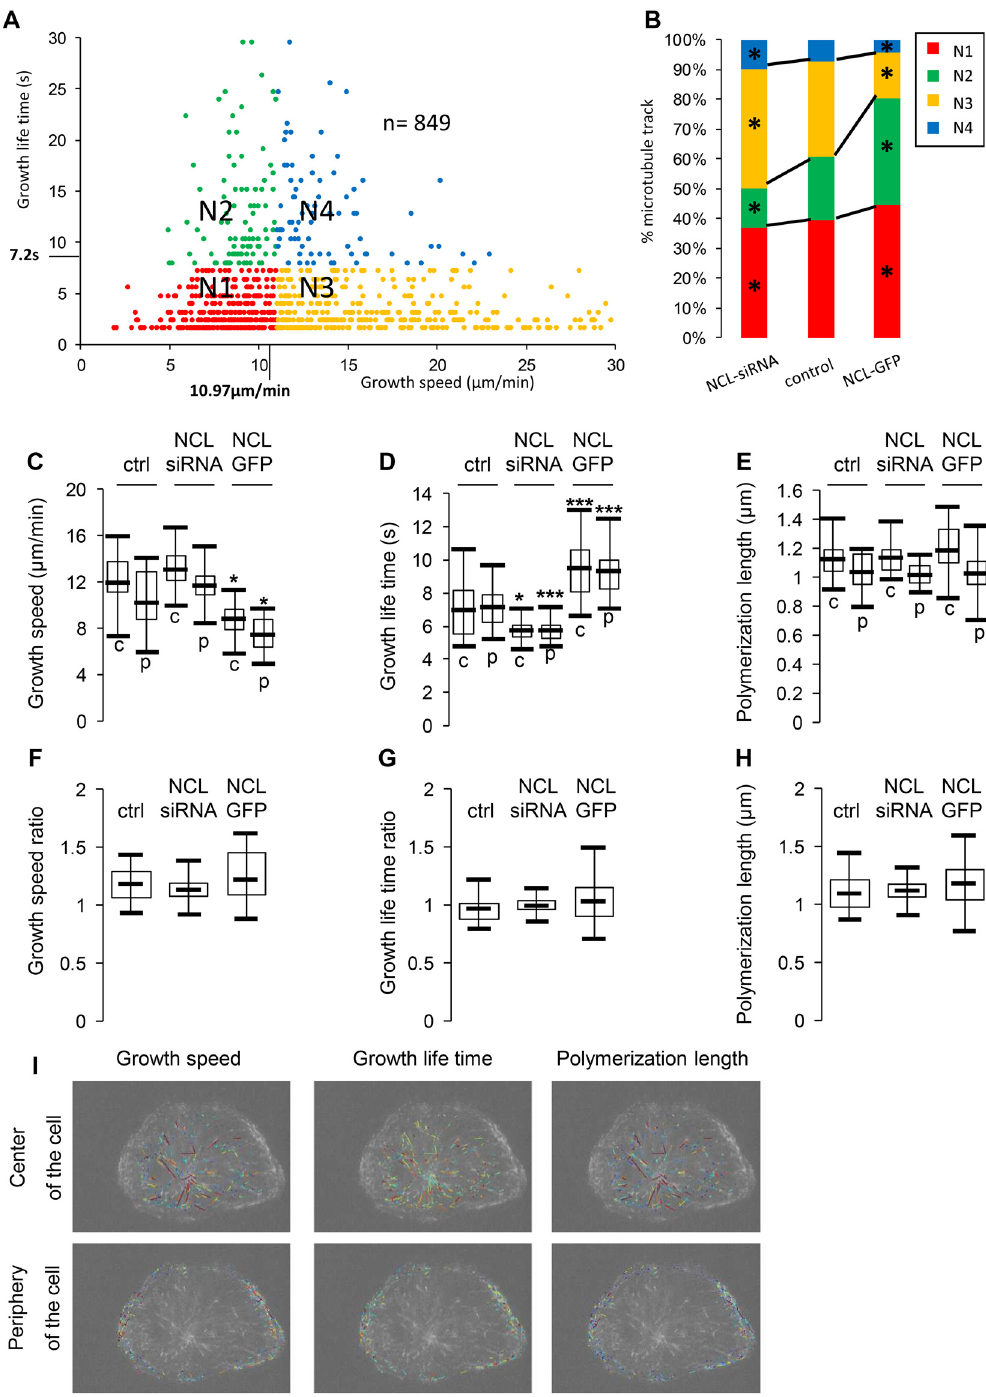
Fig 4. Nucleolin expression affects all microtubule subpopulations. (A) Quadrant scatter plot showing the classification of microtubule growth tracks according to their growth speed (x-axis) and life time (y-axis). Example of microtubule growth tracks (849 tracks) detected in a single control cell. Microtubule growth tracks are represented by the filled circles. They are classified in four categories: N1 “ slow and short lived ” [red], N2 “ slow and long lived ” [green], N3 “ fast and short lived ” [yellow] and N4 “ fast and long lived ” [blue]. The fast and slow groups as well as the short-lived versus long-lived groups were spilt using the mean growth parameters of control cells [speed: 10.97 μ m/ min and life time: 7.2s]. (B) Effect of nucleolin on the proportion of microtubules growth tracks in